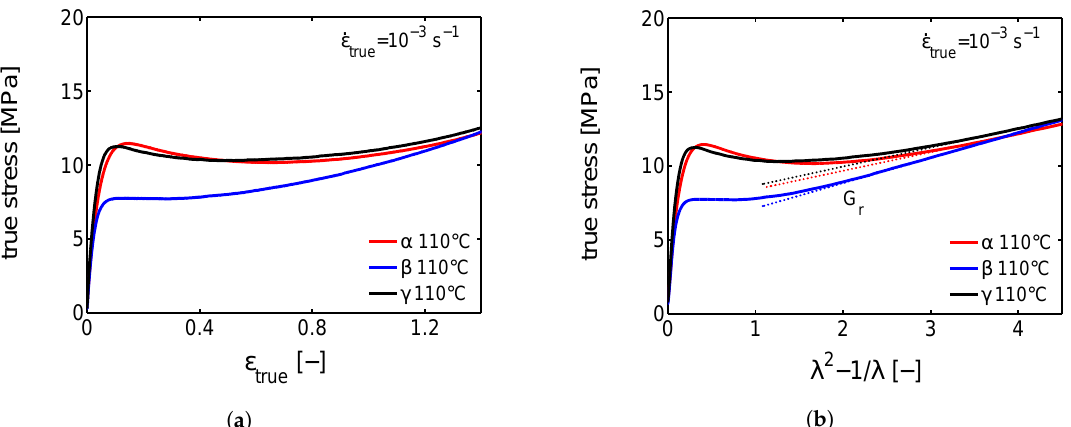
Figure 10. ( a ) The solid lines are the true stress as a function of the true strain obtained from uniaxial compression experiments on α -, β - and γ -iPP, measured at a strain rate of 10 − 3 s − 1 and a temperature of 110 ◦ C on samples with a dimension of Ø6 × 6 mm 2 ( β - and γ -iPP) or Ø3 × 3 mm 2 ( α -iPP); ( b ) The corresponding Gaussian plots for α -, β - and γ -iPP. The dotted lines represent the strain hardening moduli G r